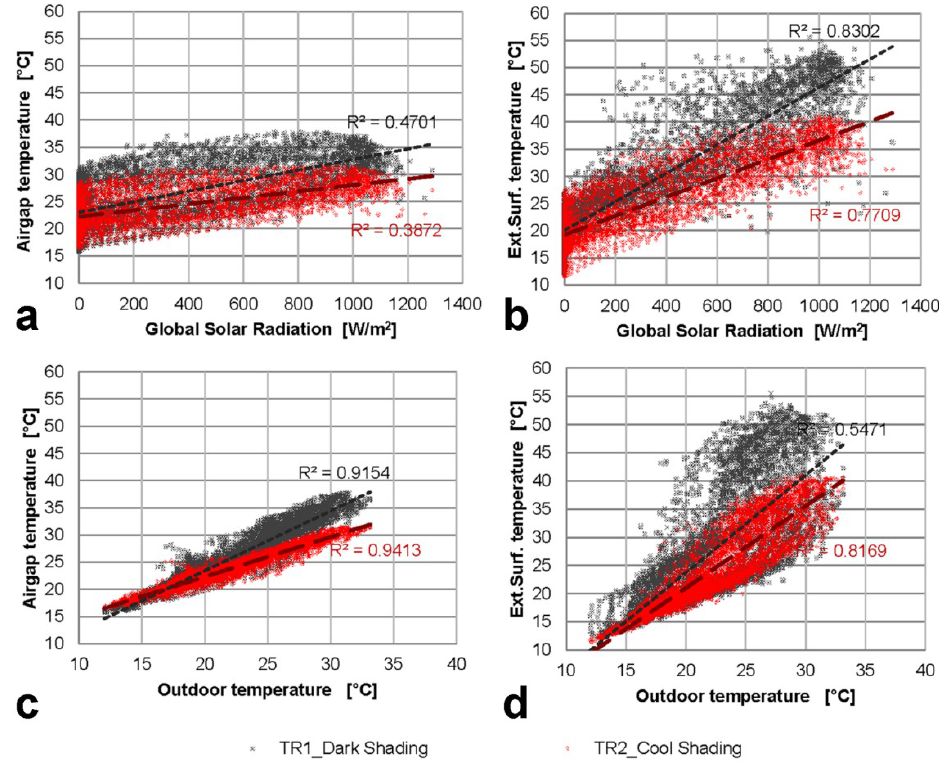
Figure 7. Air gap and surface temperature of the shutters vs. outdoor weather parameters. ( a , b ) Global solar radiation over an horizontal plane; ( c , d ) Outdoor dry bulb